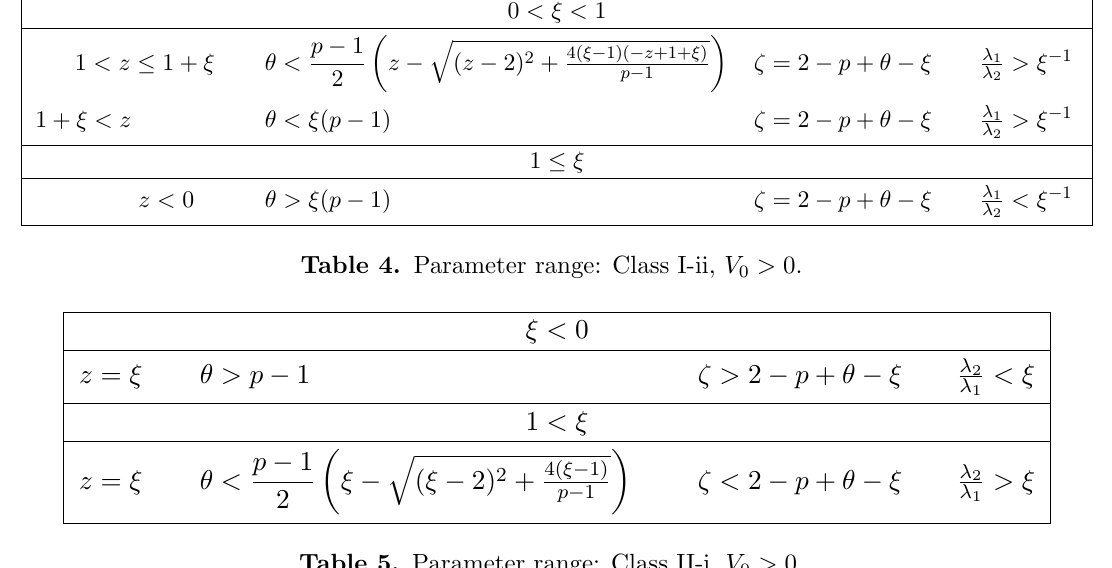
Table 5. Parameter range: Class II-i, V 0 >